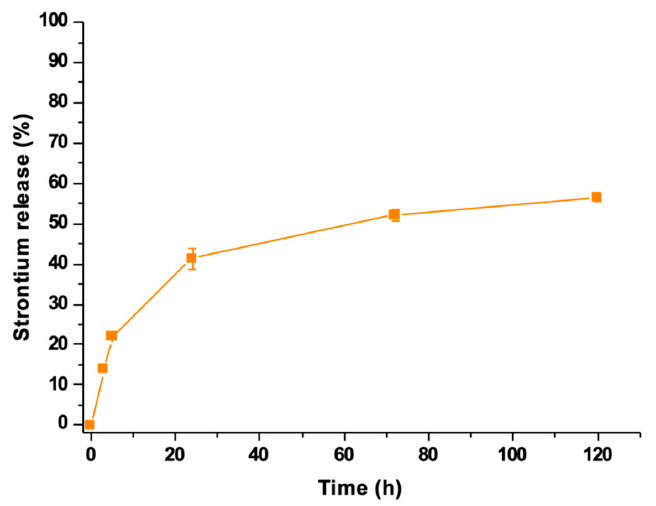
Figure 13. Sr 2+ ions release profile from the SHP_MBG_Sr_NAC hydrogel.